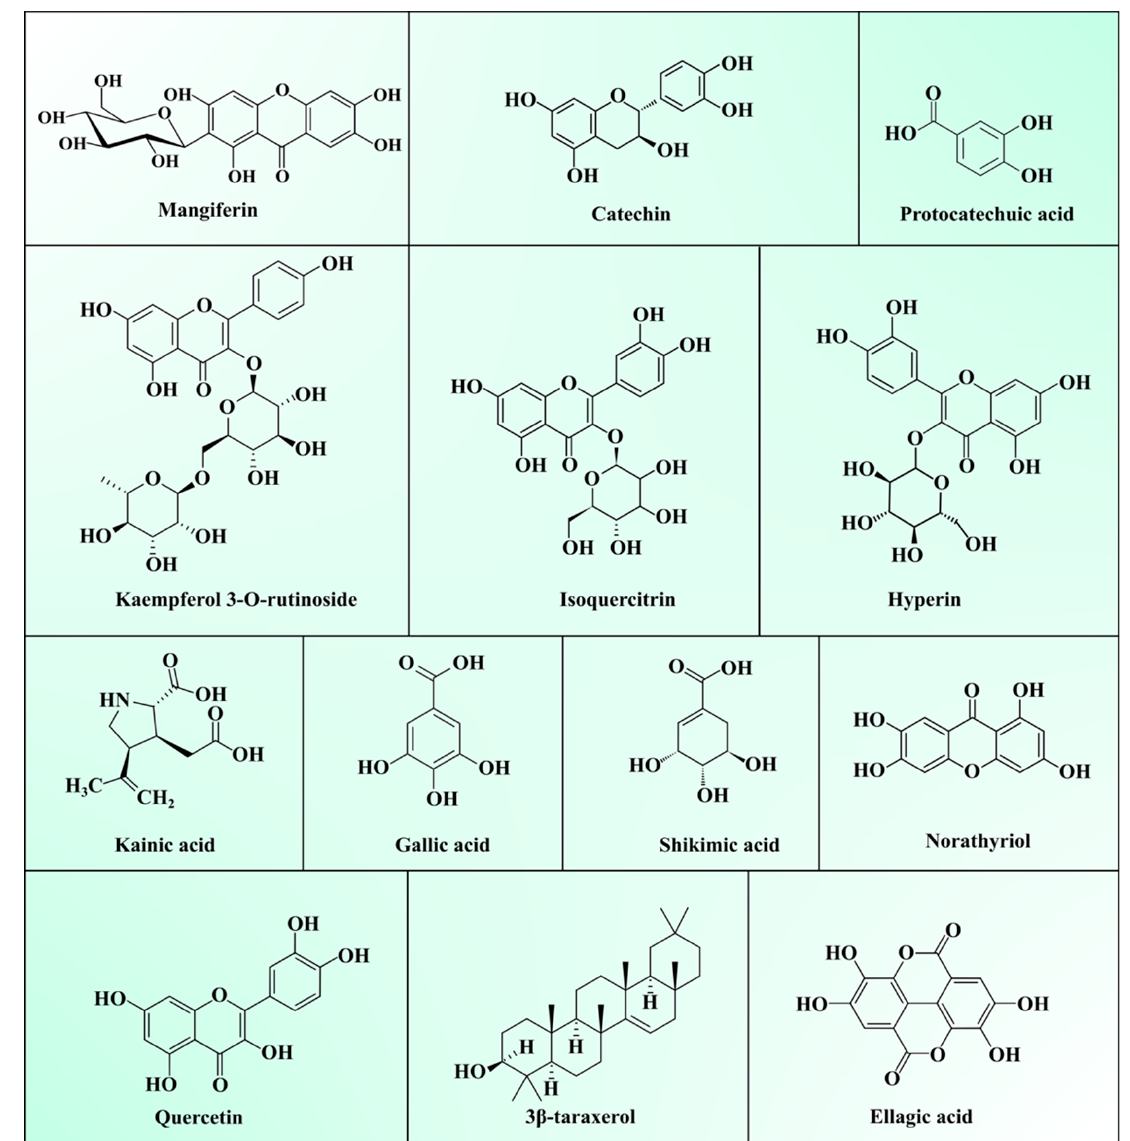
Figure 1. Structure of major compounds present in mango leaves. TPCs possess an aromatic benzenoid-ring attached to a hydroxyl group. Among all TPCs, mangiferin particularly is a potential bioactive compound in ML. In recent years, diets enriched with bioactive compounds are getting much attention due to their potential to minimize the risks of several chronic diseases’ development. Pan et al. [30] stated mangiferin (7.43%) is a major constituent in ML extract, whereas other compounds reported in higher concentration include quercetin-3-O- β -Dglucoside (0.82%), quercetin-3- O- β -D-galactoside (0.86%), and isoswertisin (1.25%). Mangiferin is a natural xanthonoid polyphenol antioxidant and plays role in ameliorating insulin resistance, modulating glucose metabolism, lowering cholesterol synthesis, and inhibiting the expression of the inducible nitric oxide synthase and TNF α [34]. TPC and total flavonoid content in crude, MeOH, and EtOAc extracts of ML was reported as 230, 99, and 186, and 131, 46, and 191 mg/g, respectively. The phytochemical investigation of MeOH, EtOAC, and crude extracts of ML using ultra high-pressure liquid chromatography (UPLC)-MS/MS identi- flavanols, four derivatives of gallotannins, four xanthones, and seven terpenoids.